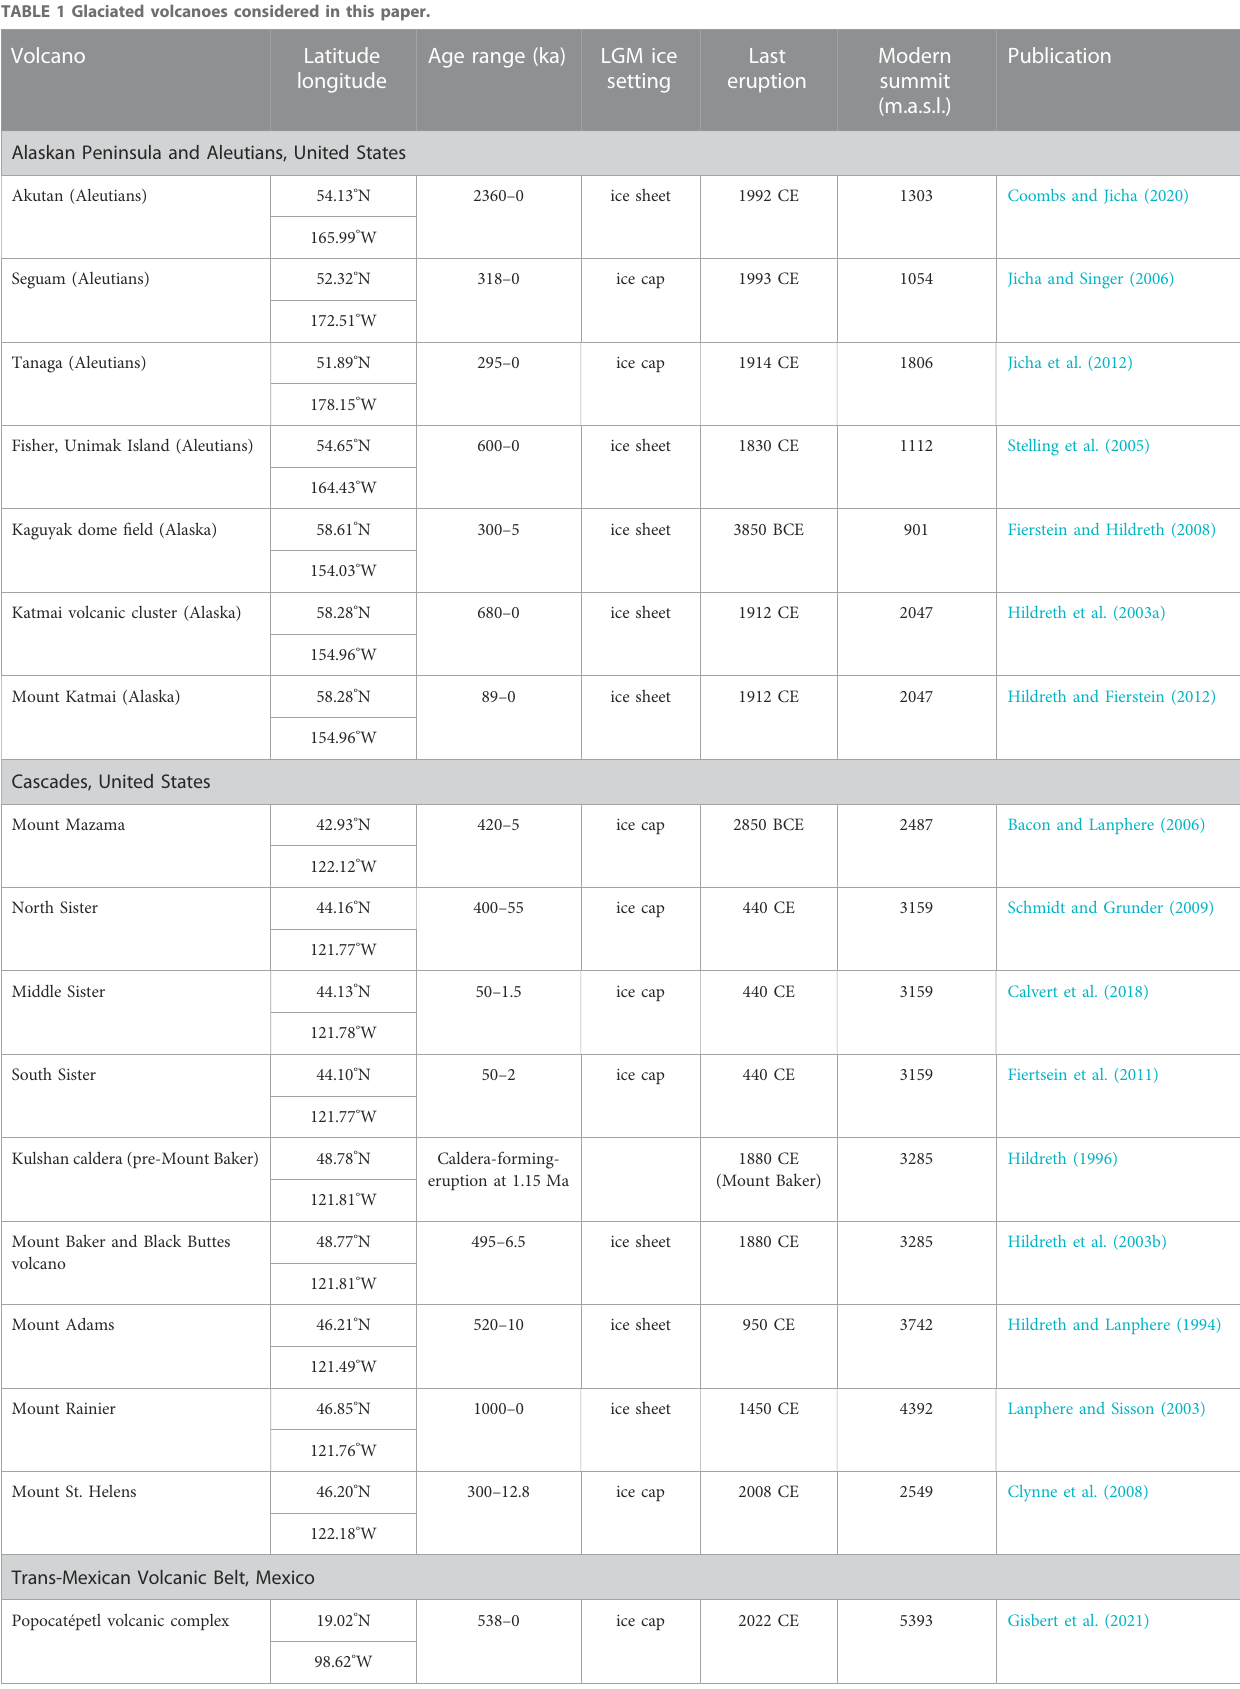
TABLE 1 Glaciated volcanoes considered in this paper.